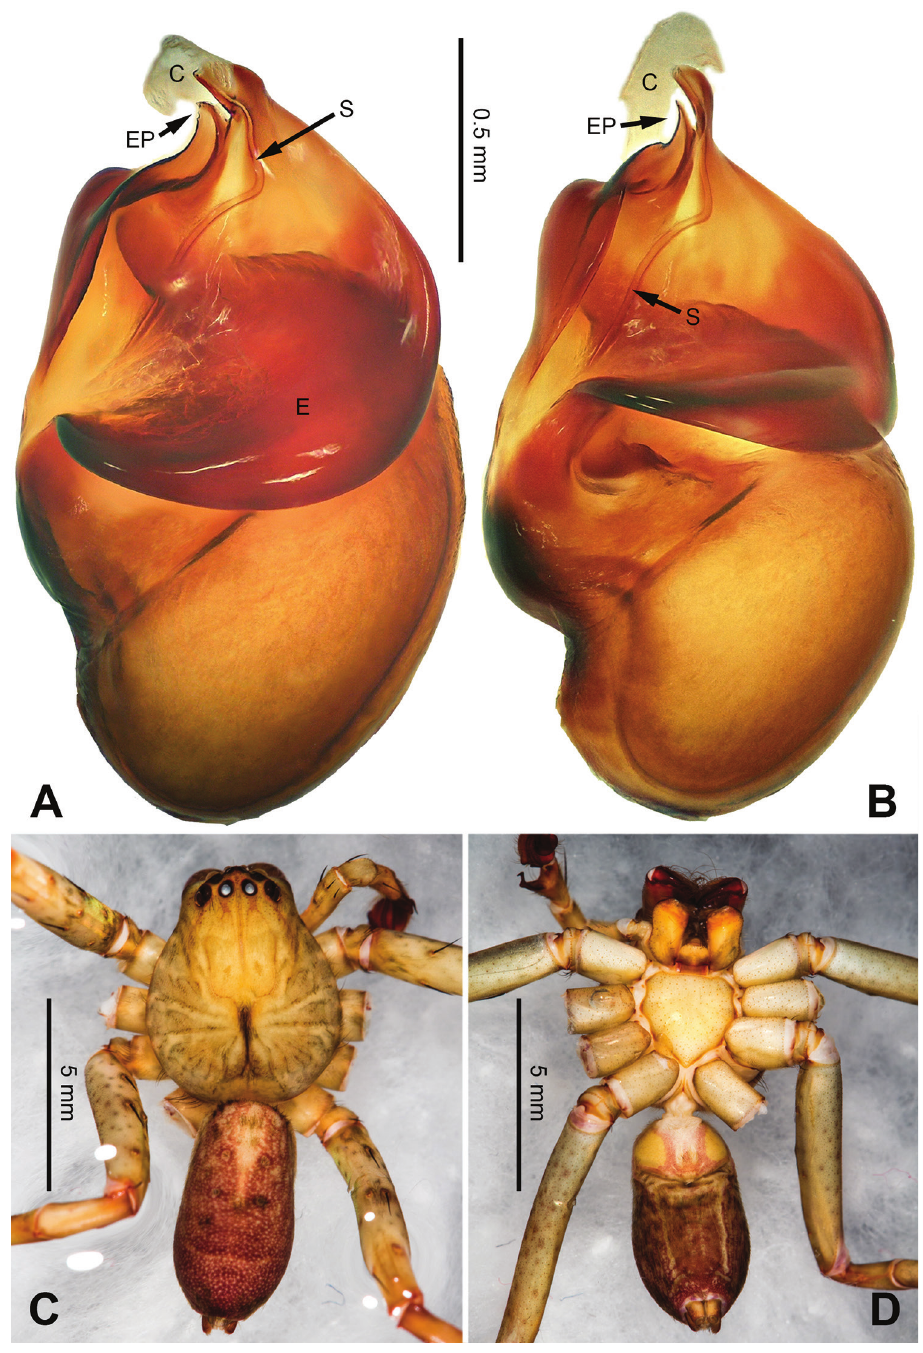
Figure 9. Pseudopoda daxing Zhao & Li, sp. n., male holotype. A Bulb, ventral view B Bulb, dorsal view C Habitus, dorsal view D Habitus, ventral view. Scale bar equal for A, B